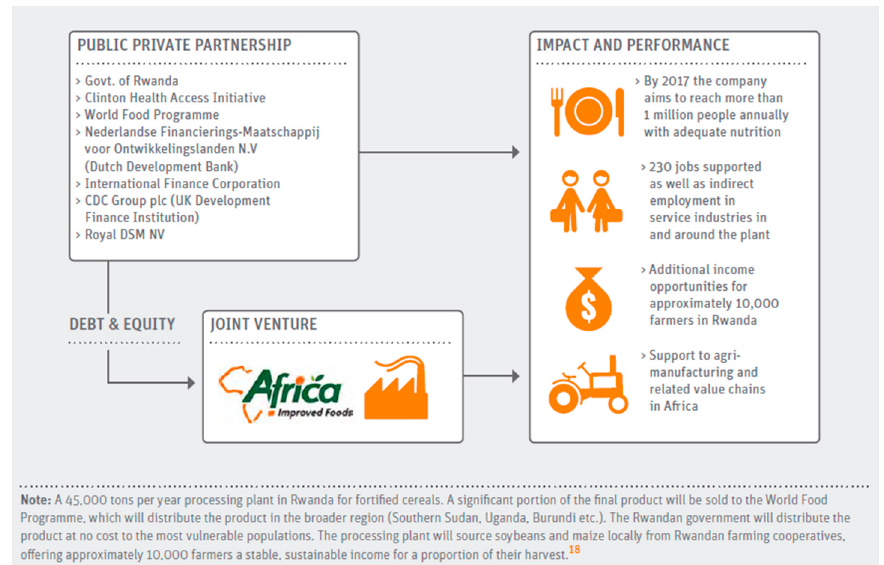
Figure 2. Impact of investing through a public–private partnership model in Rwanda [44].